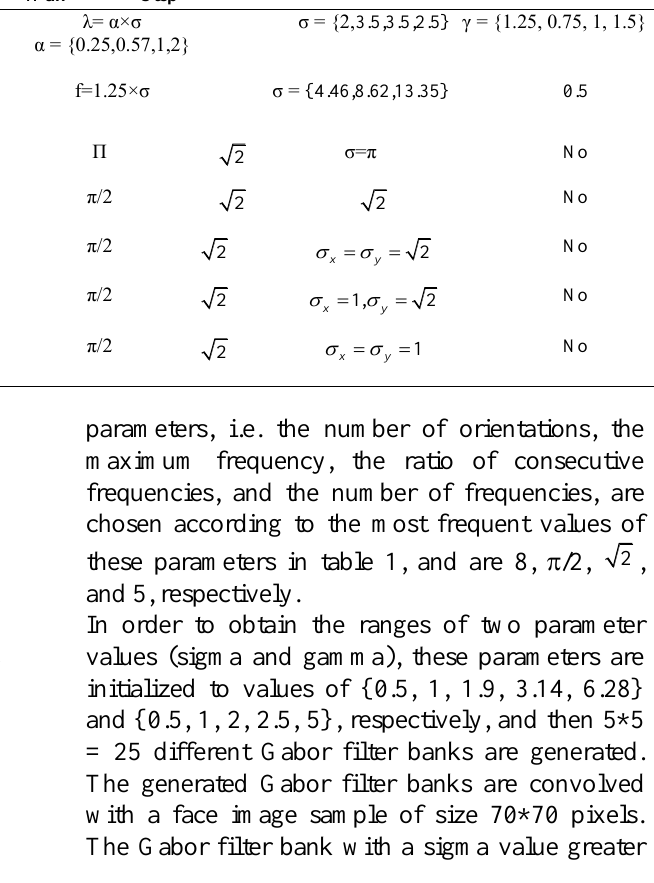
Aspect ratio Standard (gamma) Deviation